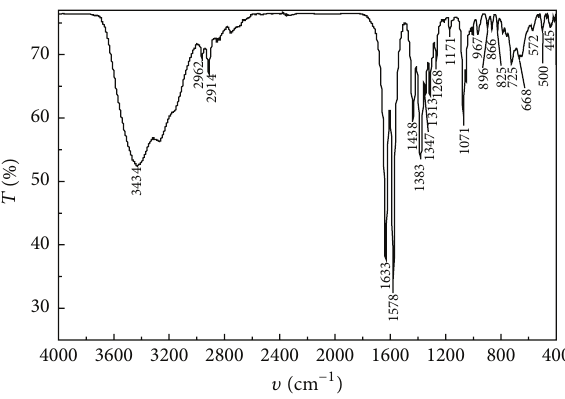
Figure 2: FTIR spectrum of the complex Mn ( HMHA ) 2 .